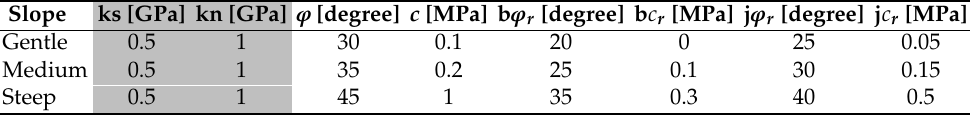
Table 2. Geomechanical properties of the discontinuities: bedding planes ( b ) and rock joints ( j ); residual properties are marked by the suffix r (ks-joint shear stiffness; kn—joint normal stiffness; ϕ —friction angle; c —cohesion).